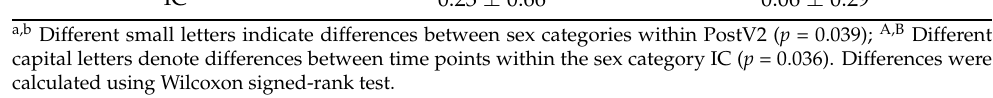
Table 2. Number of penis biting events per animal (mean ± std) in two different behavior observation phases (PreV2: P1+P2; PostV2: P3+P4) displayed for the two relevant sex categories (EM = entire males, IC = immunocastrates). Sex PreV2 PostV2 EM 0.16 ± 0.68 0.20 ± 0.47 a IC 0.23 ± 0.66 A 0.06 ± 0.29 bB a,b Different small letters indicate differences between sex categories within PostV2 ( p = 0.039); A,B Different capital letters denote differences between time points within the sex category IC ( p = 0.036). Differences were calculated using Wilcoxon signed-rank test.